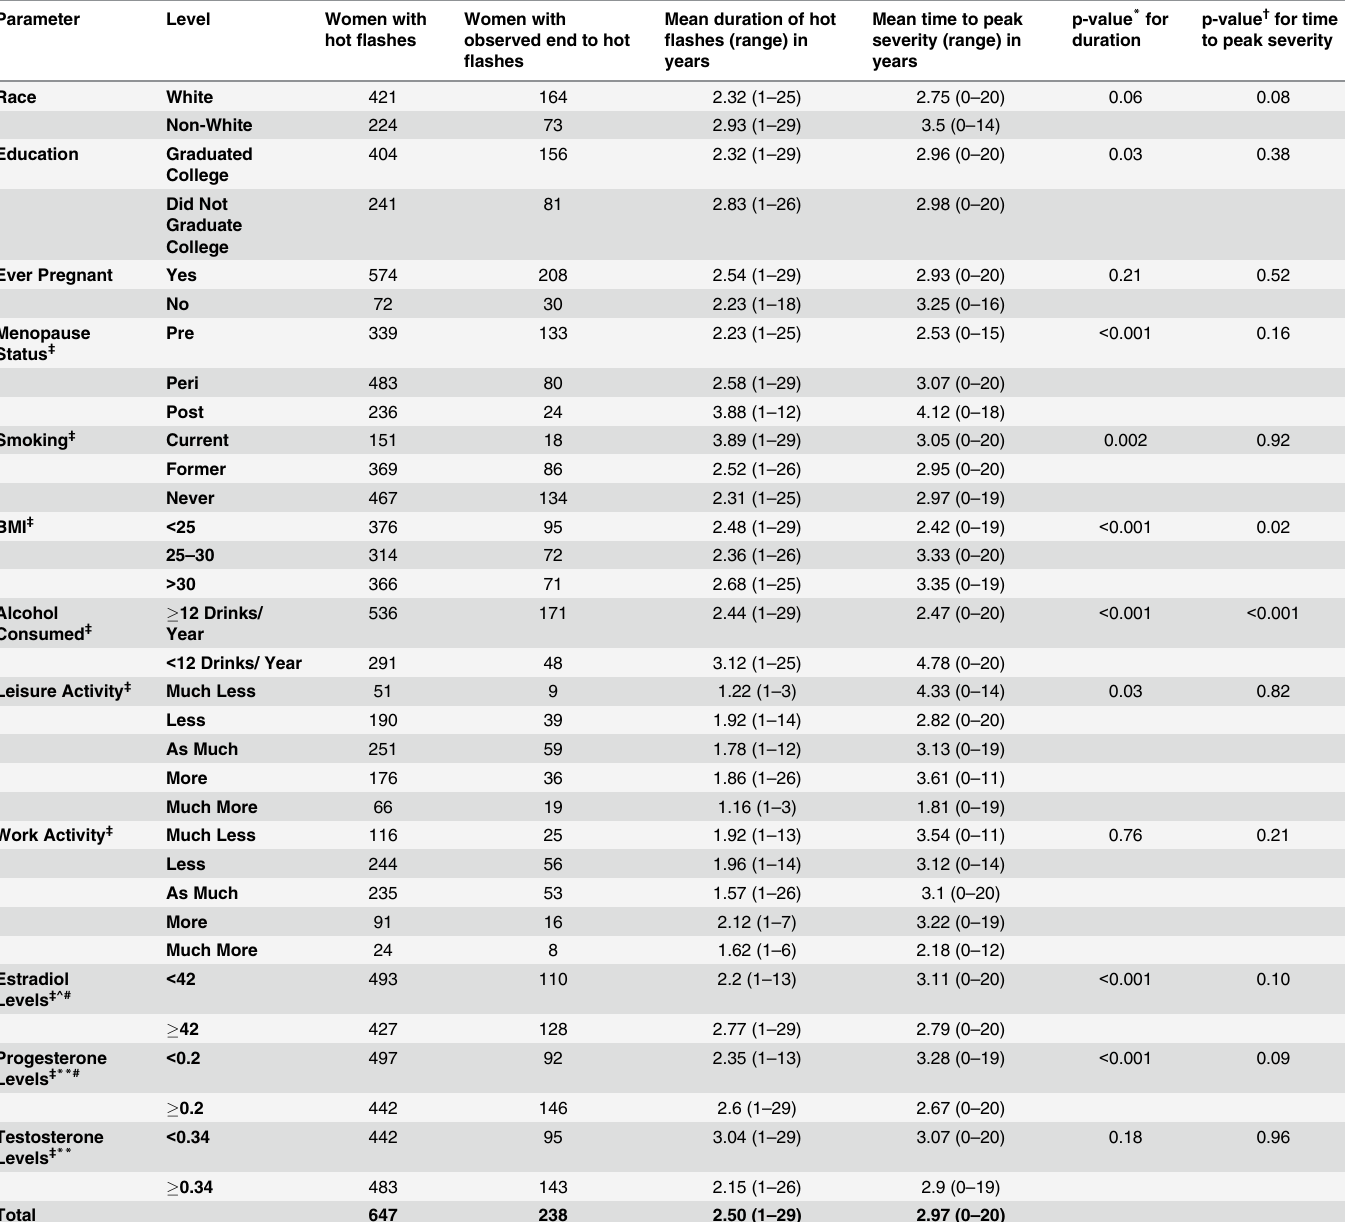
Table 1. Description of data used to study the effects of various risk factors on the duration of hot flashes in US women aged 45 –